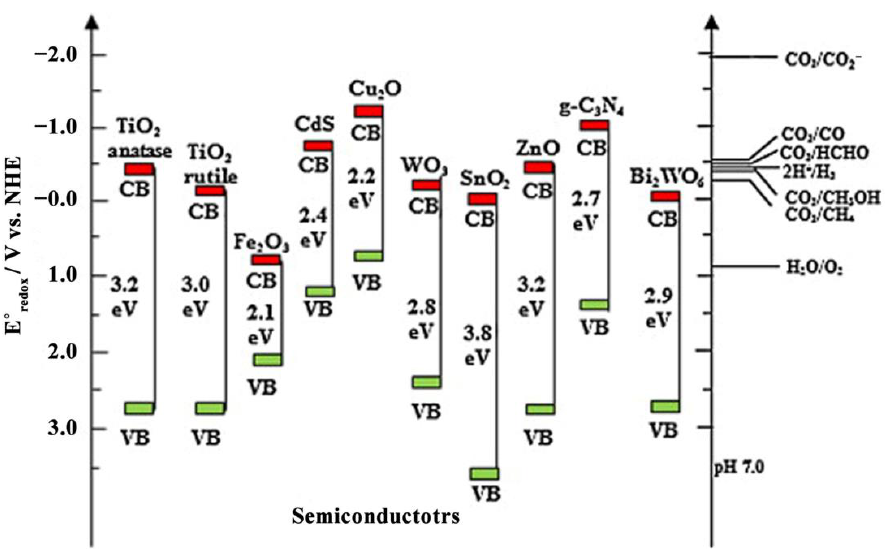
Figure 4. Band gap of major semiconductors (with respect to the redox potential of various chemical species measured at pH 7). Reprinted with permission from Ref. [88]. Copyright 2015, Elsevier.